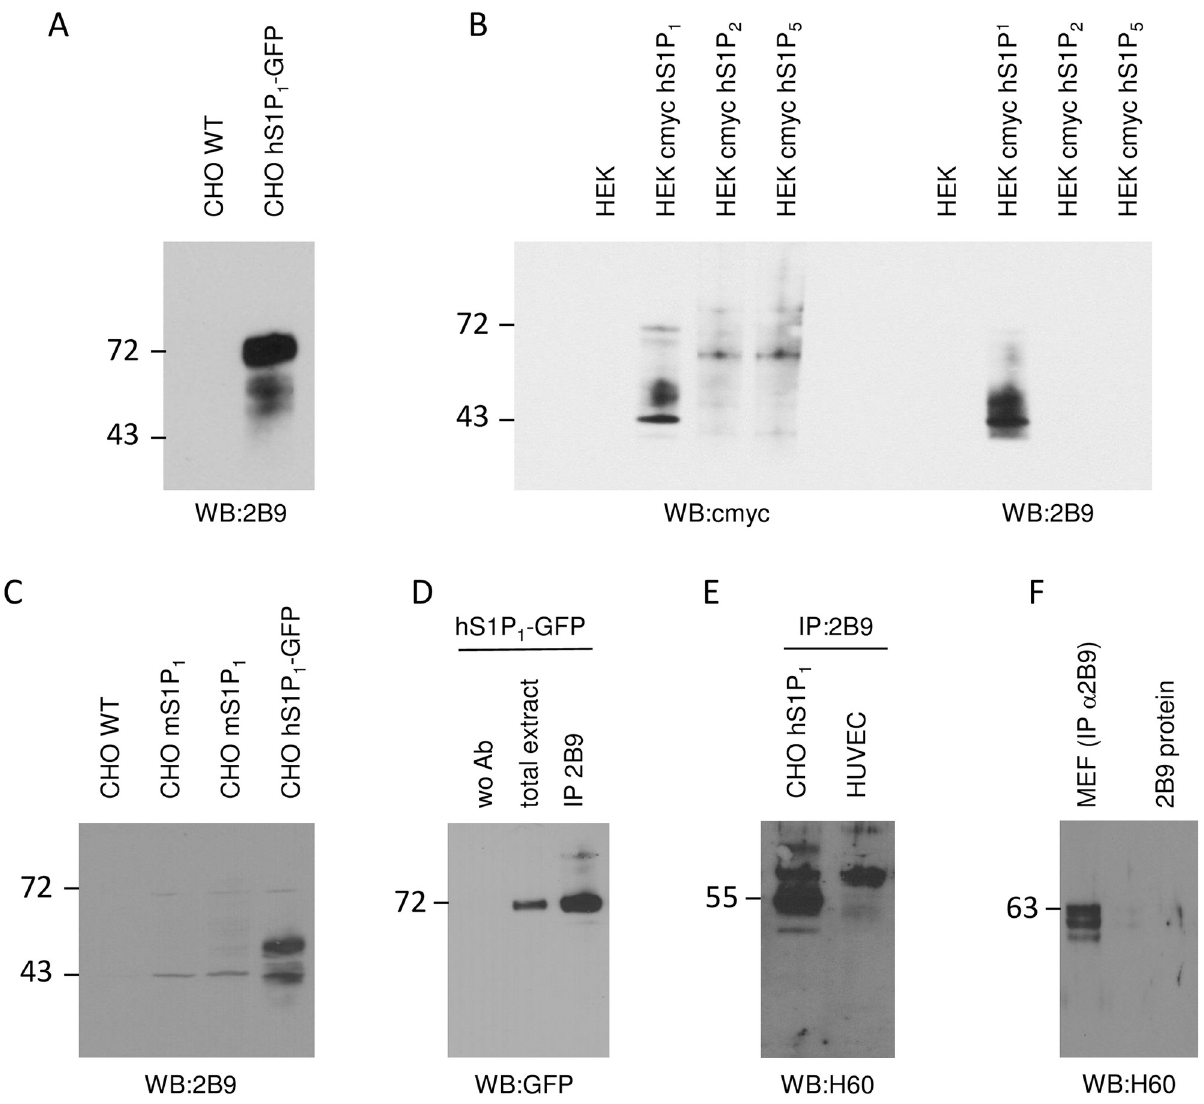
Fig 3. Detection of receptors in membranes from recombinant CHO and HEK cells by Western blot and in HUVEC and MEF after immunoprecipitation. A Expression of hS1P 1 in control CHO WT cells and in CHO cells stably expressing hS1P 1 -GFP using 2B9 antibodies (1:5,000 w/v dilution). B HEK cells were transfected with vector expressing cmyc-hS1P 1 , cmyc-hS1P 2 or cmyc-hS1P 5 . Expression of the receptors was detected 48 hours later using cmyc (1:1,000 v/v) and 2B9 (1:5,000 w/v) antibodies. C Detection of mouse S1P 1 in control CHO WT cells, CHO cells stably expressing mS1P 1 and CHO cells stably expressing hS1P 1 -GFP using 2B9 antibody (1:1,000 w/v). D Human S1P 1 was immunoprecipitated from CHO cells stably expressing hS1P 1 -GFP using 2B9 antibody and detected with rabbit anti-GFP antibodies (1:2,000, v/v). Negative control was realized with no antibodies and positive control with a detergent-solubilized extract. E Endogenous human S1P 1 was immunoprecipitated from HUVEC cells using 2B9 antibody and detected with rabbit anti-S1P 1 H60 antibodies (1:1,000, v/v). CHO hS1P 1 were used as positive control. F Endogenous mS1P 1 was immunoprecipitated from MEF membrane fraction using 2B9 antibodies and detected with rabbit anti-S1P 1 H60 antibodies (1:1,000, v/v). 2B9 proteins were used as a control.